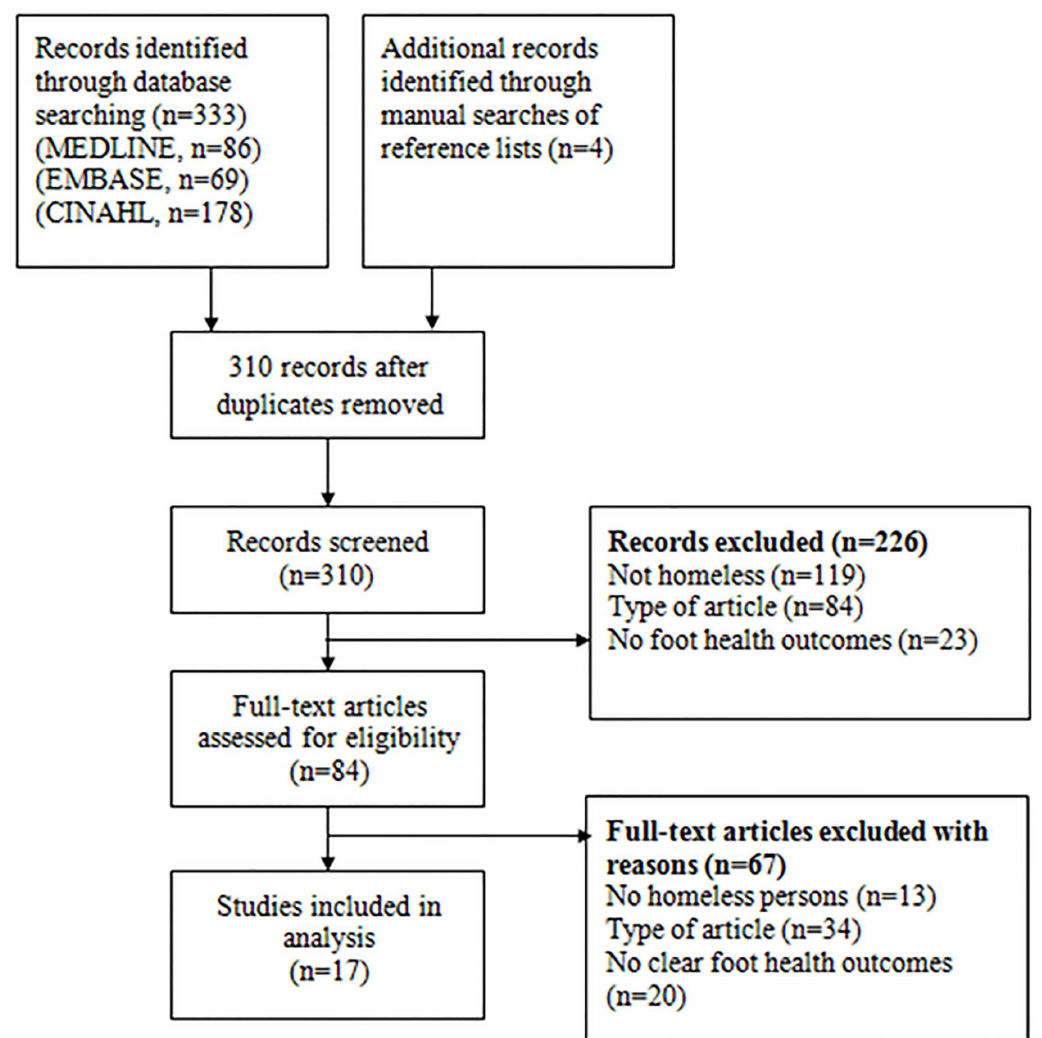
Fig 1. Flow diagram of articles identified, screened,and included in